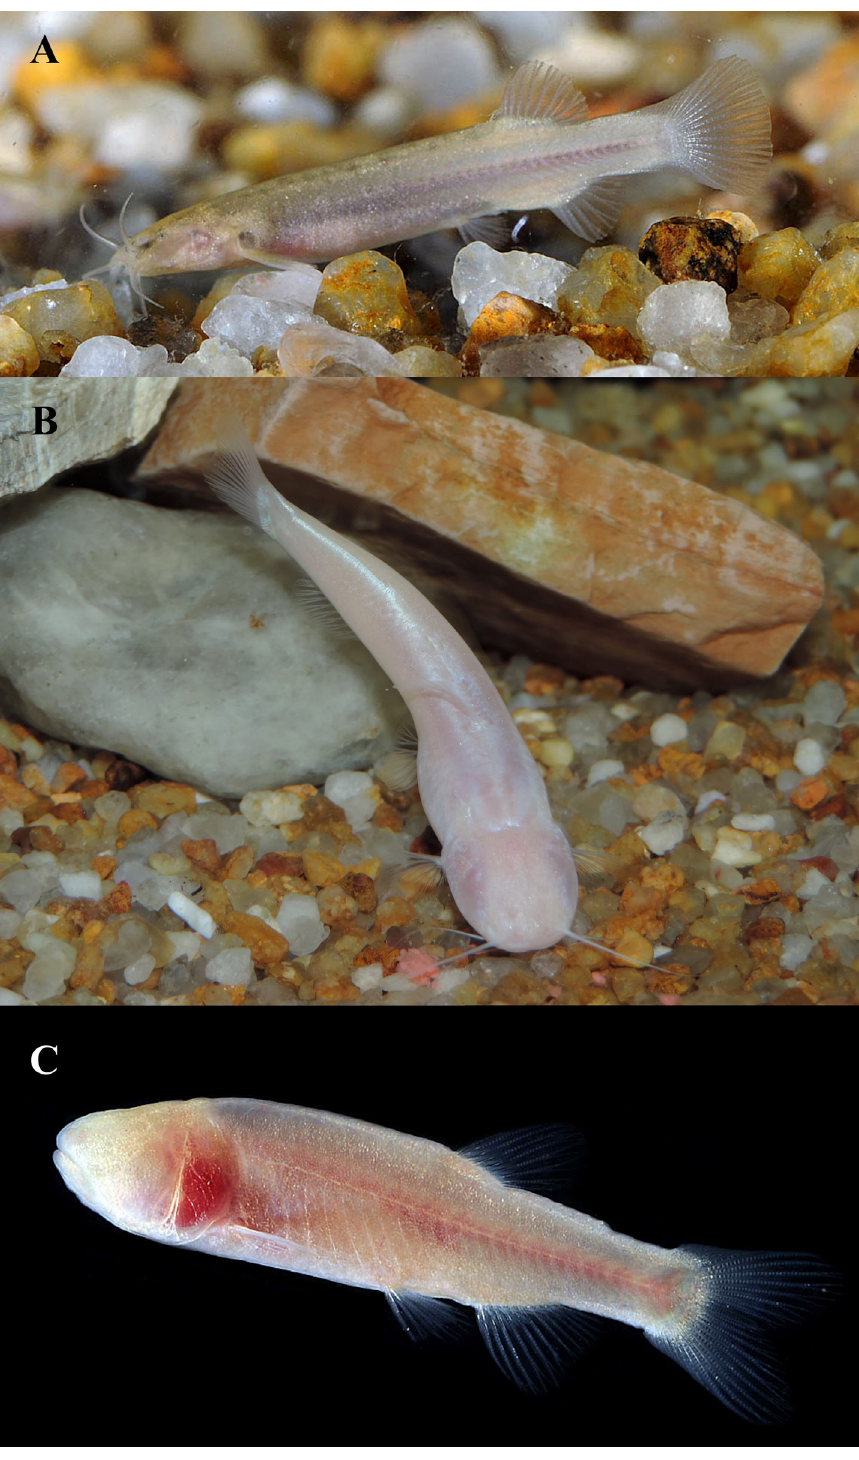
FIGURE 5 | A. Ituglanis epikarsticus from the Lapa do São Mateus cave, São Domingos, Goiás State, live specimen, 28 mm SL; Photo: Adriano Gambarini. B. Rhamdiopsis sp. “caatinga”, live specimen, 59 mm SL; Photo: Jonas Eduardo Gallão. C. Stygichthys typhlops from the Jaíba region, Minas Gerais State, live specimen, 25 mm SL, specimen captured in July 2008; Photo: Adriano Gambarini. All specimens were photographed in an aquarium at Laboratório de Estudos Subterrâneos, Universidade Federal de São